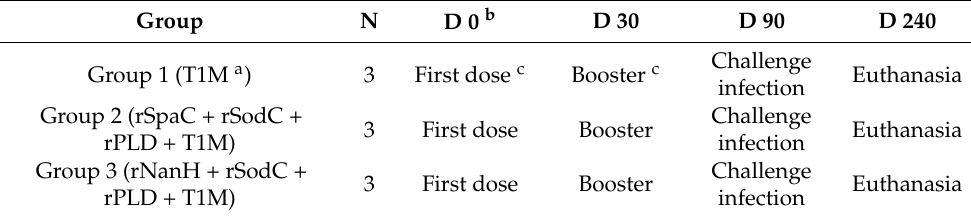
Challenge Euthanasia infection Challenge infection